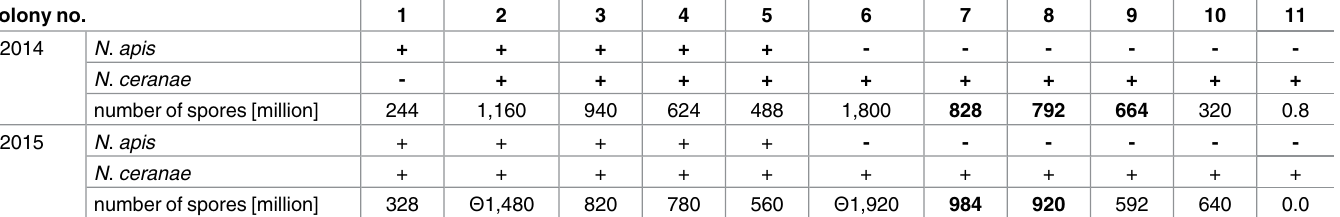
Table 1. Infection types and intensities in the Nosema spp. infected colonies. Colony